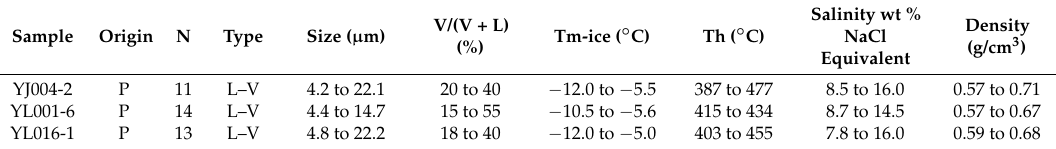
Table 4. Fluid inclusion microthermometric data of the garnet from Yongping Cu deposit.